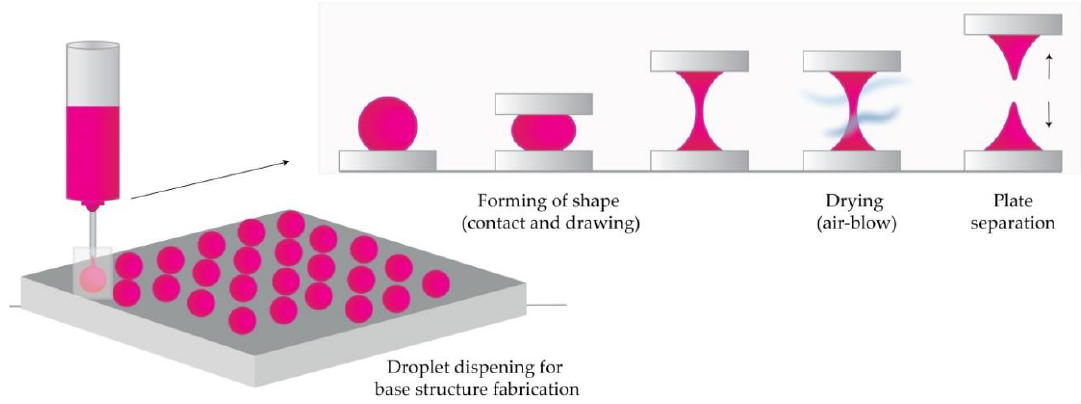
Figure 7. The principle of droplet-born air blowing (DAB) methods (Modified from